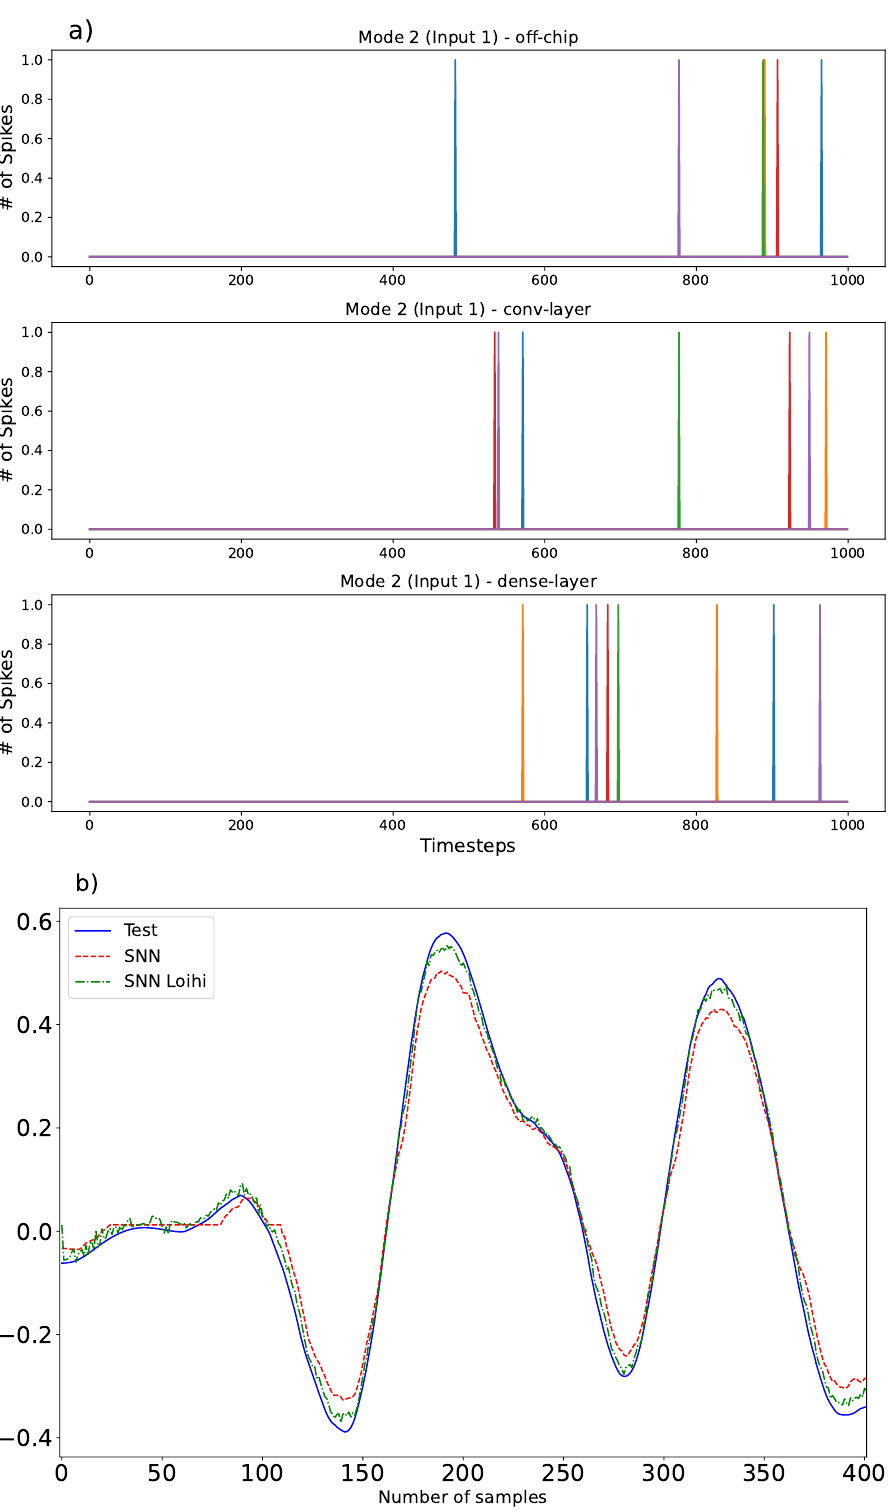
Figure 8. Results for mode 2: ( a ) Neural activities of 5 neurons of each layer. One input vector is shown over 1000 timesteps. ( b ) Predictions over the testing set with the SNN architecture (dashed red line) and running the SNN on the Loihi emulator (dash-dot green